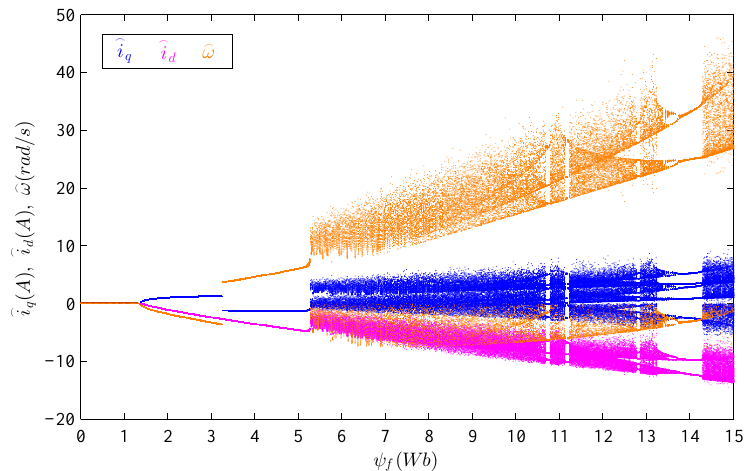
Figure 8. Bifurcation diagram of the D-SPMSG system (24) versus ψ f